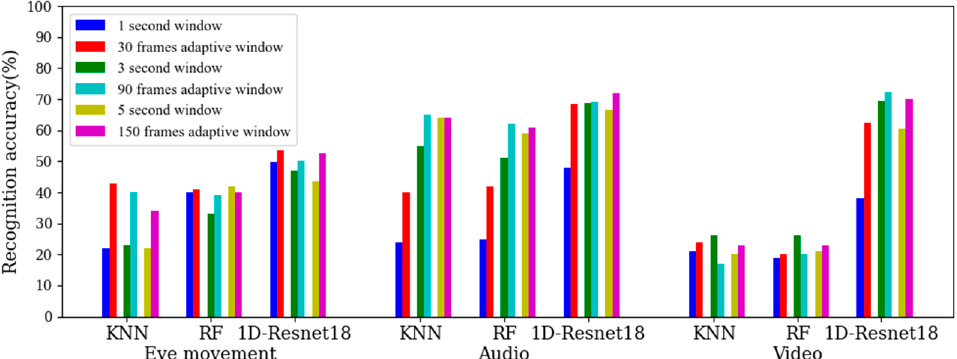
Figure 10. The recognition accuracies for the AWSs and SWSs.